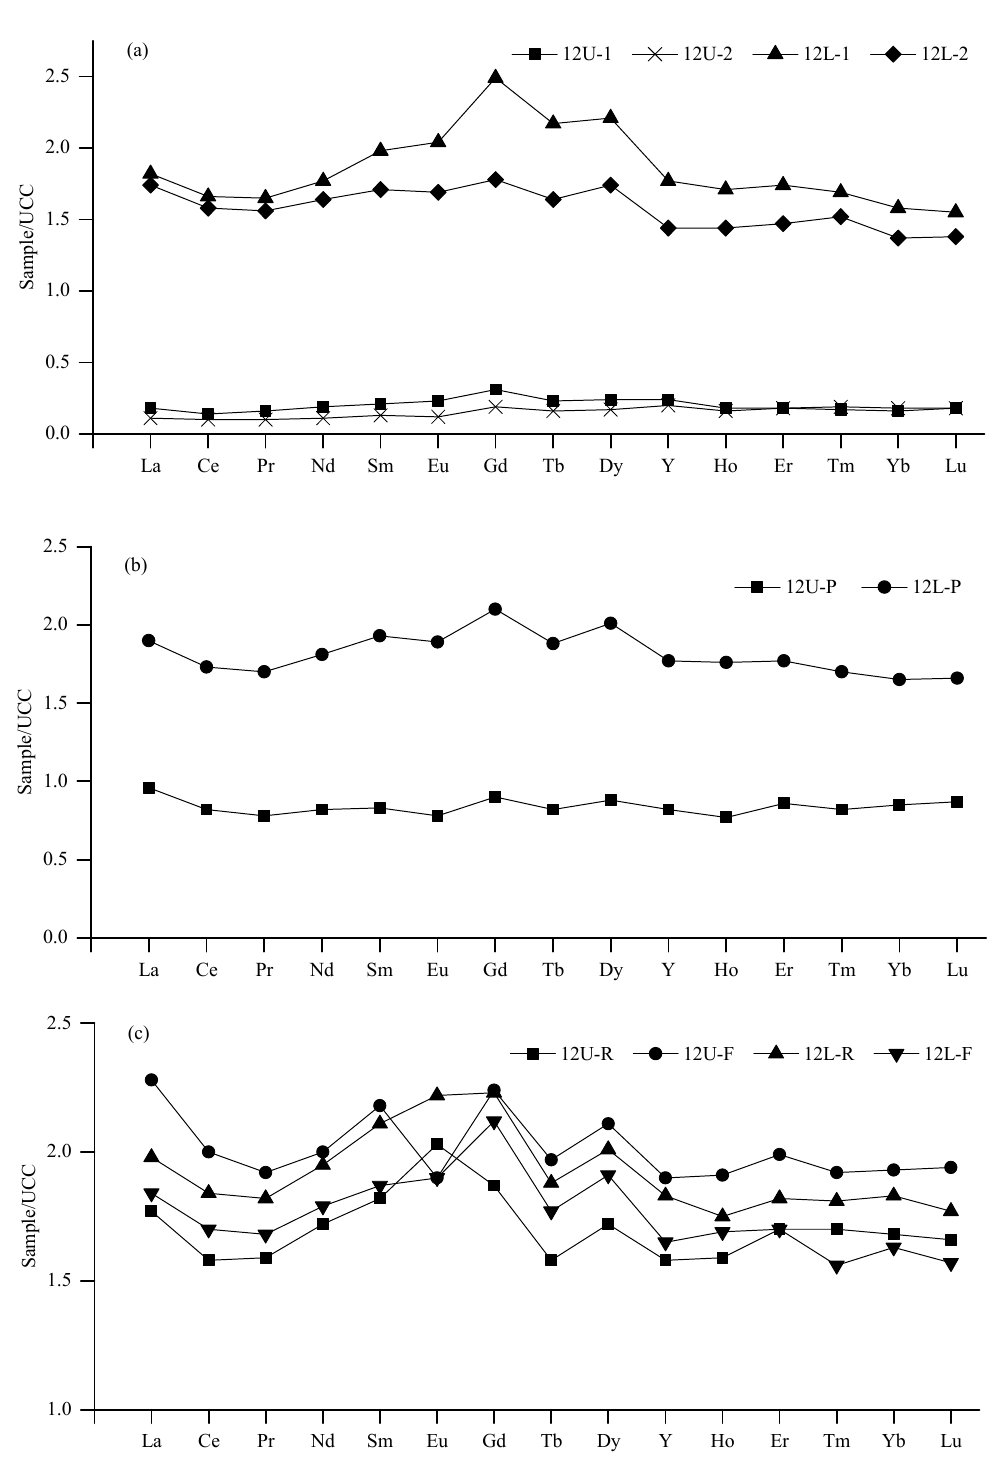
Figure 4. Distribution patterns of REY in coal benches ( a ), partings ( b ), and roofs and floors ( c ). REY are normalized by upper continental crust concentrations (UCC) [43].